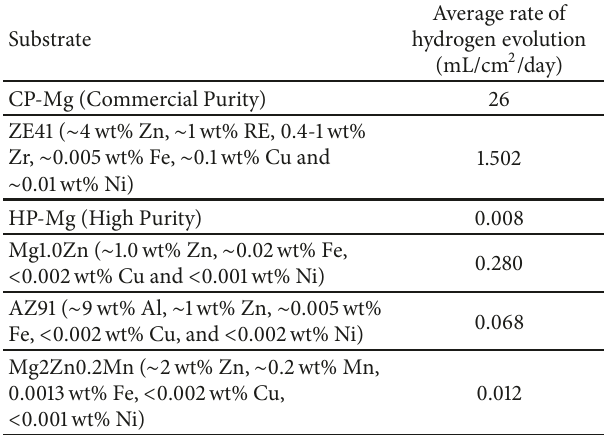
Table 3: Average rate of hydrogen evolution for various Mg alloys